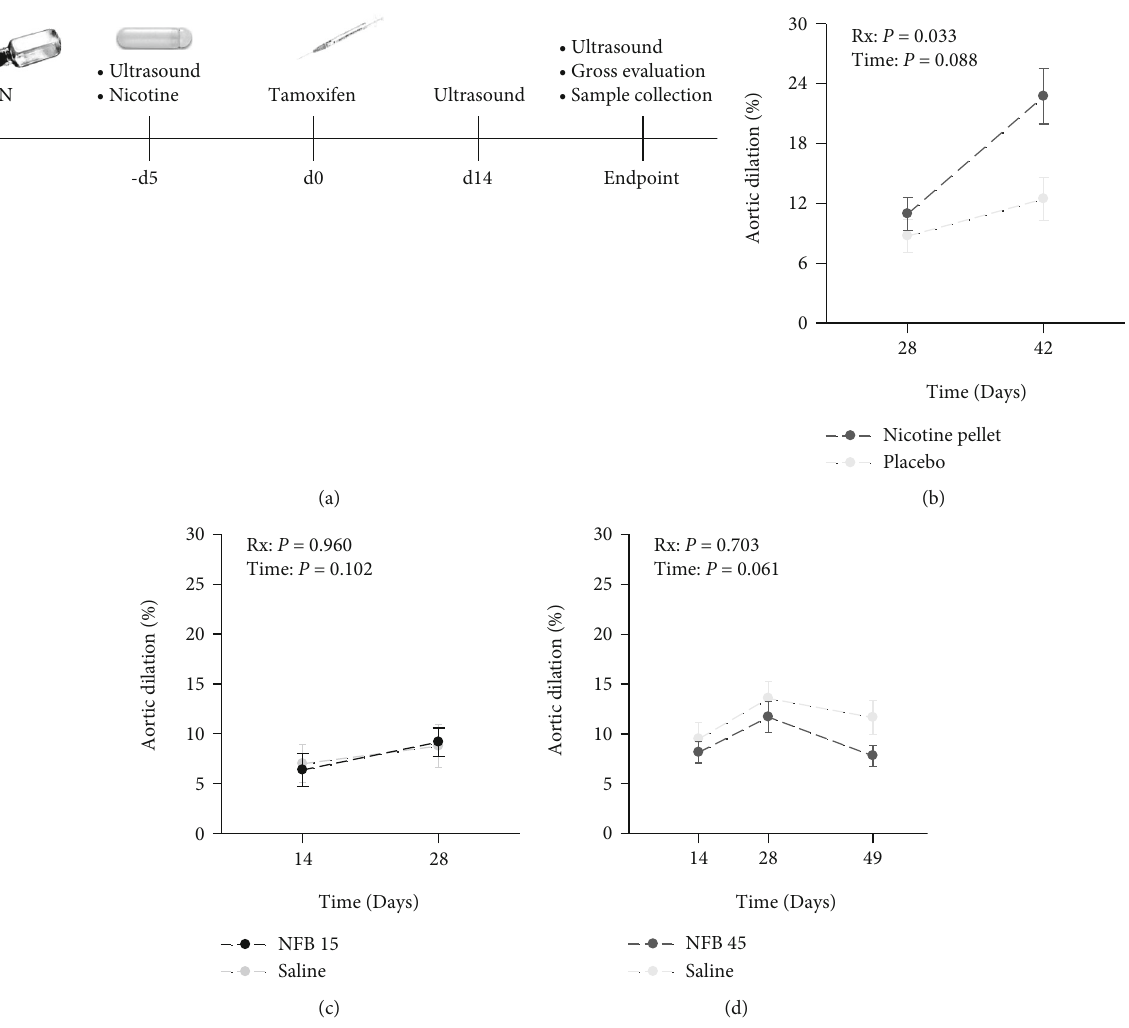
Figure 1: Nicotine free base (NFB) exacerbates TAAD formation only at a lethal dosage. (a) Experimental timeline schematic for drug administration and procedures. (b) Aortic dilation of mice that survived the initial burst of NFB release ( n = 7 ). Control mice ( n = 10 ) were implanted with placebo pellets. (c, d) Aortic dilation of mice infused with NFB at a rate of 15.0 (NFB 15) or 45.0 (NFB 45) mg/kg/day or saline ( n = 8 ‐ 9 per group). Data were analyzed using two-way repeated measures